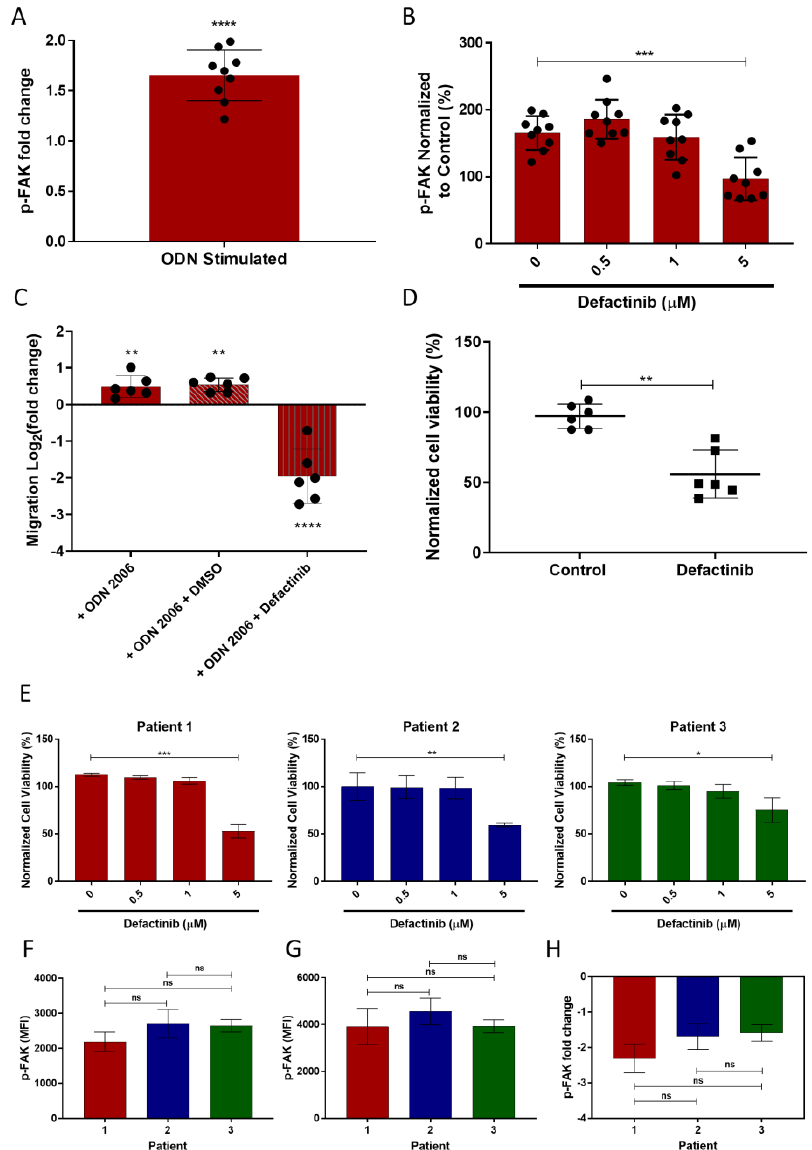
Figure 3. Stimulating CLL cells through TLR9 causes an increase in p-FAK and migration, which was abrogated by FAK inhibition. ( A ) PBMCs from three different CLL patients were incubated with or without ODN2006 for 24 h in triplicate and the p-FAK levels were assessed by flow cytometry. The mean fluorescence intensity was determined for both groups and the fold change in p-FAK was calculated. ( B ) Alongside TLR9 stimulation, CLL cells were treated with a range of defactinib concentrations for 24 h and the subsequent p-FAK levels were measured. ( C ) CLL cells from six patients were incubated with or without ODN2006 and treated with a vehicular control or defactinib (5 µM) overnight before transferring into transwell migration chambers and allowed to migrate towards a CXCL12 gradient for 4 h. The migrated cells were quantified by volumetric counting. ( D ) Defactinib induced apoptosis after 24 h treatment in the six TLR9 stimulated CLL patient samples, as assessed by 7AAD/Annexin V staining. ( E ). PBMCs from three different patients with CLL were incubated overnight with or without stimulation with ODN2006 with or without co-treatment with defactinib (0 – 5 μ M). The percentage cell viability for the CLL cells with and without defactinib treatment for 24 h was determined by Annexin V/7-AAD staining ( F ) The levels of p-FAK were assessed by flow cytometry before ODN stimulation ( G ) Post-ODN stimulation. ( H ) p-FAK fold change after 24 h defactinib treatment in ODN stimulated CLL cells. **** p ≤ 0.0001 *** p ≤ 0.001, ** p ≤ 0.01, * p ≤ 0.05 .